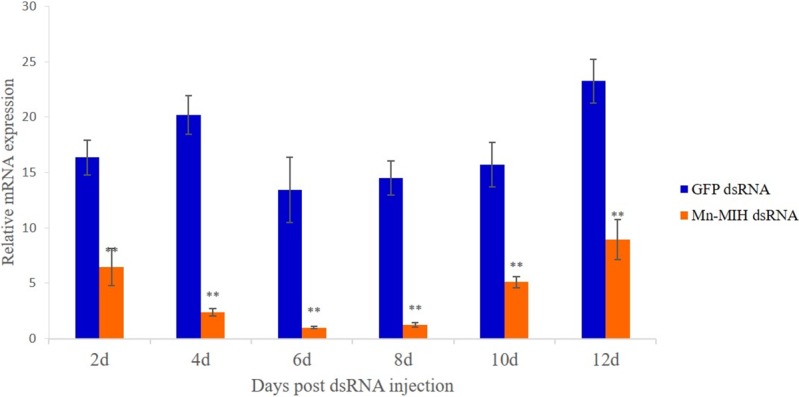
Efficiency of RNAi-mediated knockdown in eyestalks of M. Nipponense.Different letters denote significant differences (P < 0.05). Error bars represent the mean± standard error.